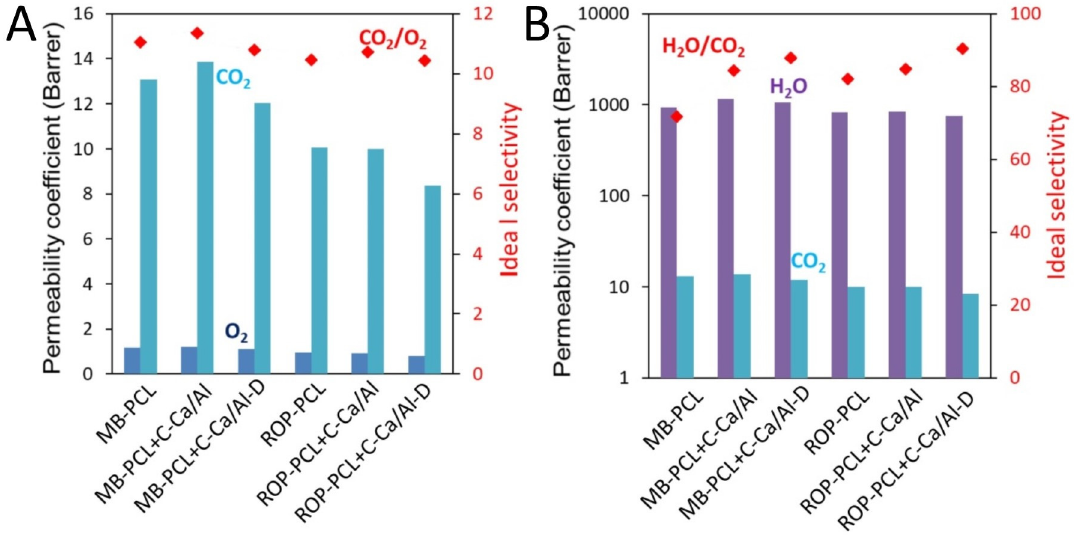
Figure 4. Carbon dioxide, oxygen and water vapor permeability and corresponding ideal selectivity of prepared materials: CO 2 /O 2 ( A ) and H 2 O/CO 2 ( B ).